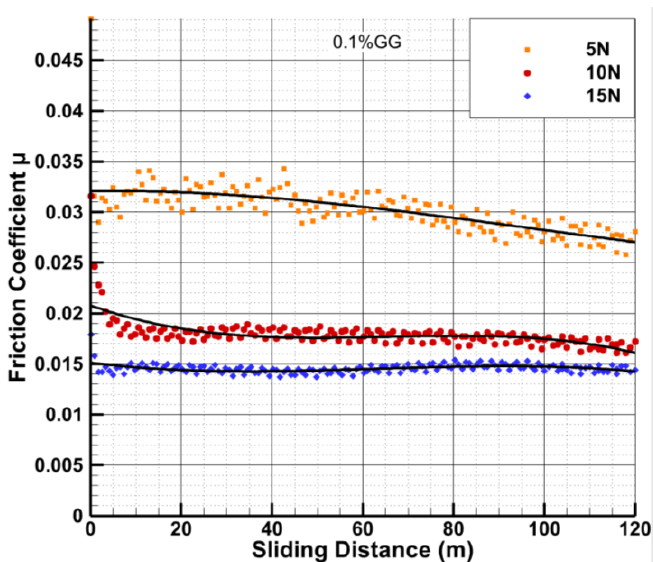
Figure 6. Friction coefficient versus sliding distance for the PVA/GG hydrogels with 0.1 wt% GG under the sliding velocity of 0.2 m/s. The results are shown for three different loads of 5, 10, and 15 N.